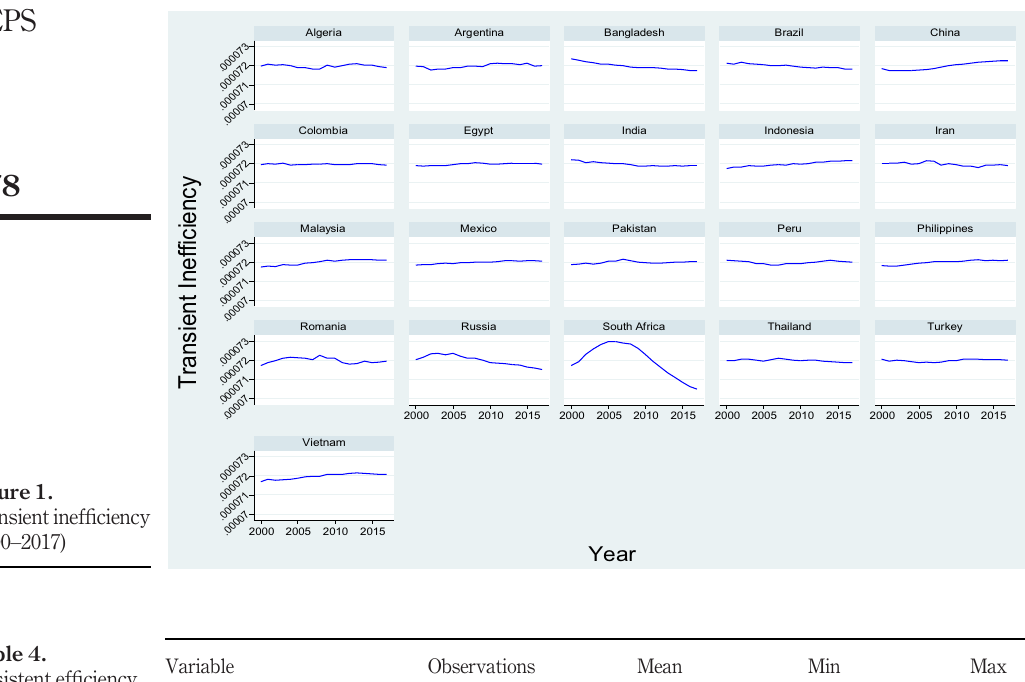
Table 4. Persistent ef fi ciency and inef fi